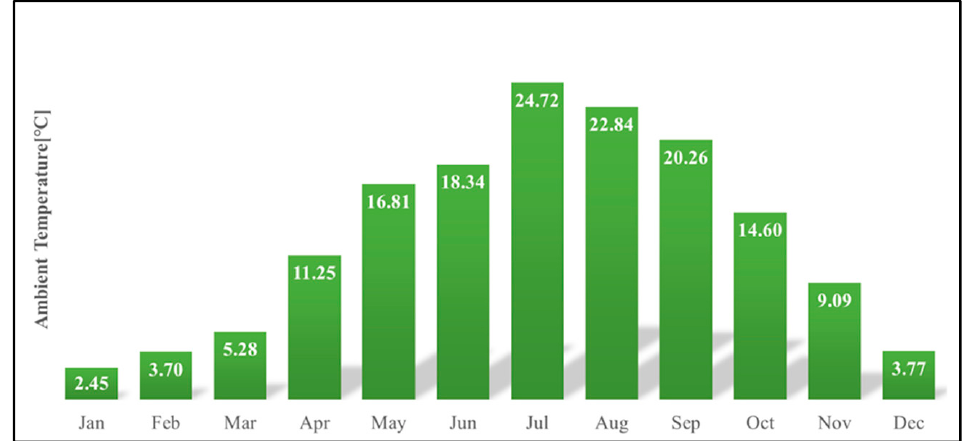
Figure 7. Monthly average temperature in Fukushima.